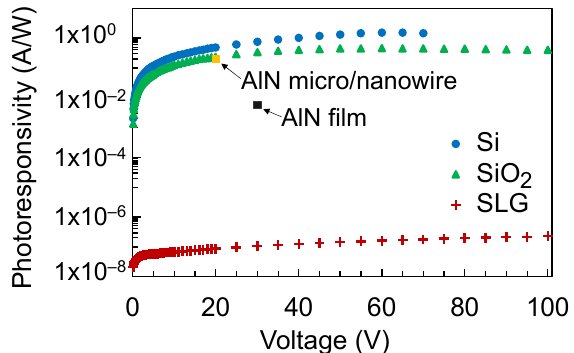
Figure 4. Photoresponsivity of TiO 2 films deposited on Si, SiO 2 , and SLG substrates at 70 V bias voltage. The photosensitivity of an AlN micro/nanowire and AlN film from previous reports [10] are also shown for comparison. Table 1. Photosensitivity and photoresponsivity of the TiO 2 thin film detectors at a bias voltage of 70 V.